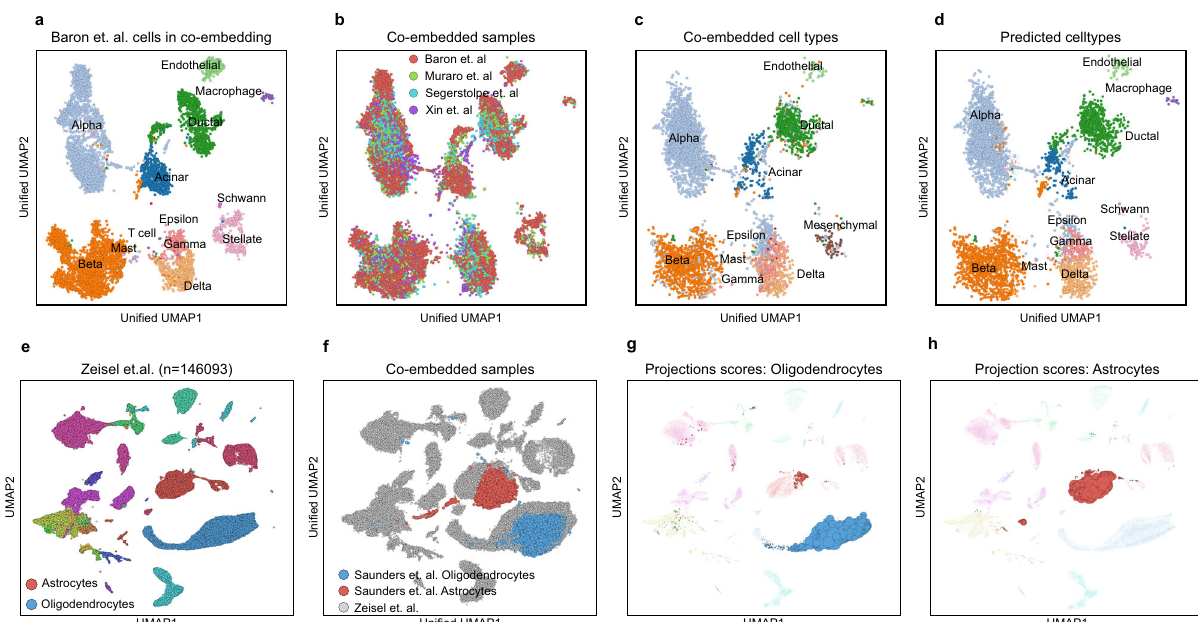
Fig. 6 | Co-embedding multiple datasets and cell type-speci fi c mapping with Scarf.a ScatterplotshowingpancreaticcellsfromBaronetal.intheco-embedding spacethatwascreatedusingthesamecellsasreference.Theprojectedcellsarenot shown here, and the reference cells have been coloured according to author annotated cell types. b Co-embedding of cells after the projection of cells from three datasetsovercellsfrom Baronetal. c Cellsfromthe threeprojected datasets intheuni fi edUMAPspace.Cellsarecolouredbasedonauthor-annotatedcelltypes.